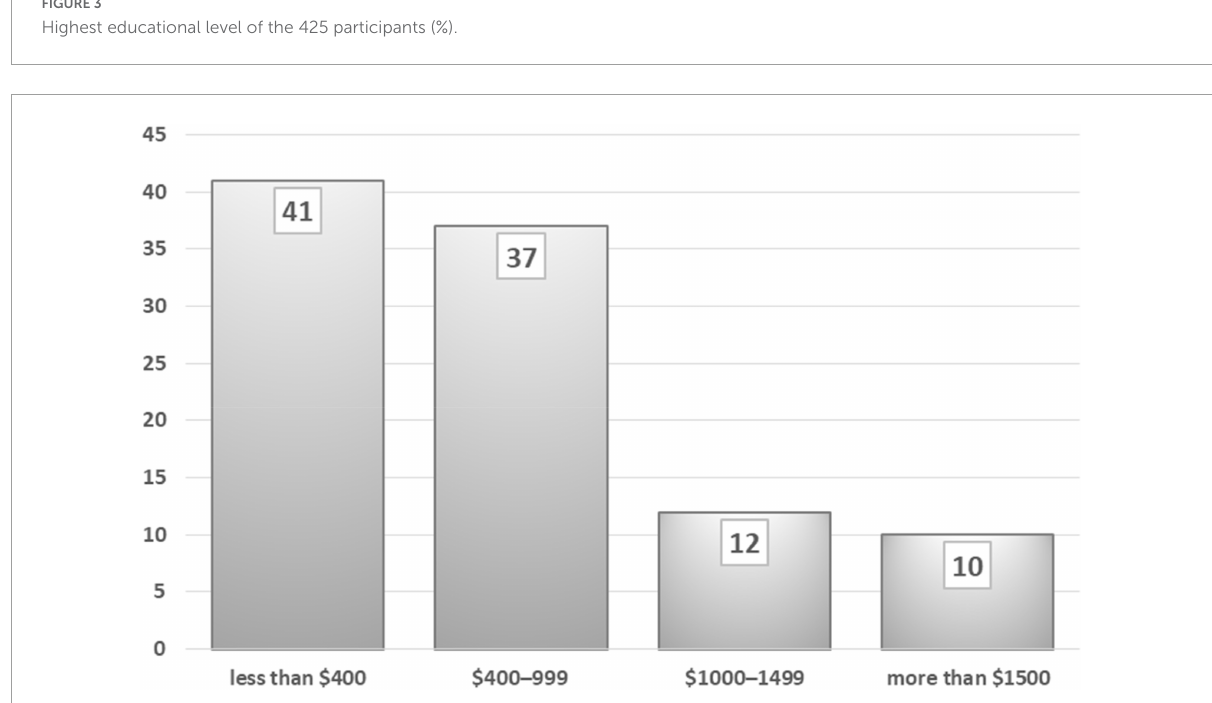
FIGURE3 Highest educational level of the 425 participants (%).